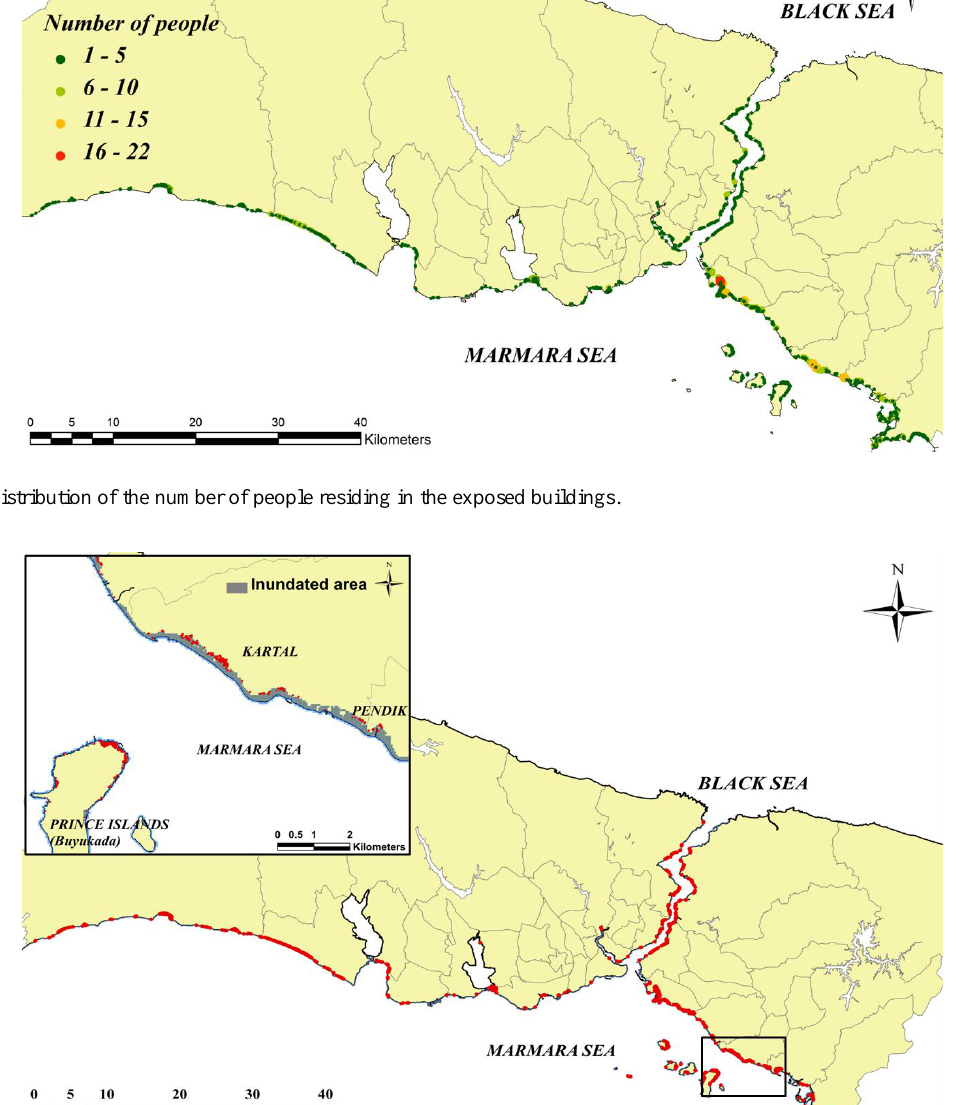
Fig. 8. The eastern coasts of the Marmara Sea as well as Beyoˇglu, Fatih and Bes¸iktas¸ districts on the European side are dense locations for public buildings. The distribution of public buildings within the inundation zone is shown in Fig. 9. The industrial buildings are mostly located in Tuzla Bay area and their spatial distribution within the inundation zone is shown in Fig. 10. The infrastructure buildings iden- tified within the inundation zone spread throughout the city; their spatial distribution within the inundation zone is given in Fig.